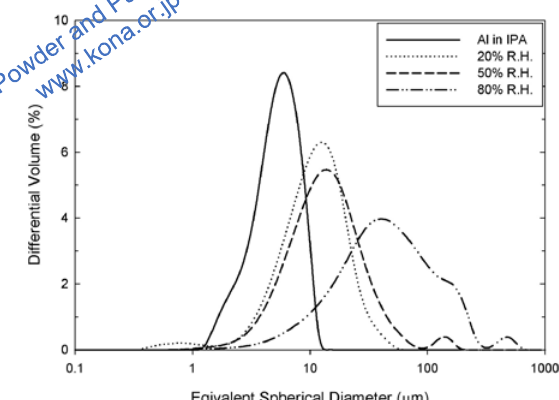
Particle size of aluminum flakes at 20, 50, and 80% relative hu- Fig. 7 midity. The graph represents change in particle size of the aluminum flakes after supercritical drying and conditioning for 48 hours at 20% relative humidity (dotted), 50% relative humid- ity (dashed), and 80% relative humidity (dotted and dashed). Plot 1 (solid) represents the primary particle size measured in isopropyl alcohol and provided as a comparison. The standard deviation for the measurement is ± 3 μ m. The change in particle size and distribution due to changes in the relative humidity can readily be seen.